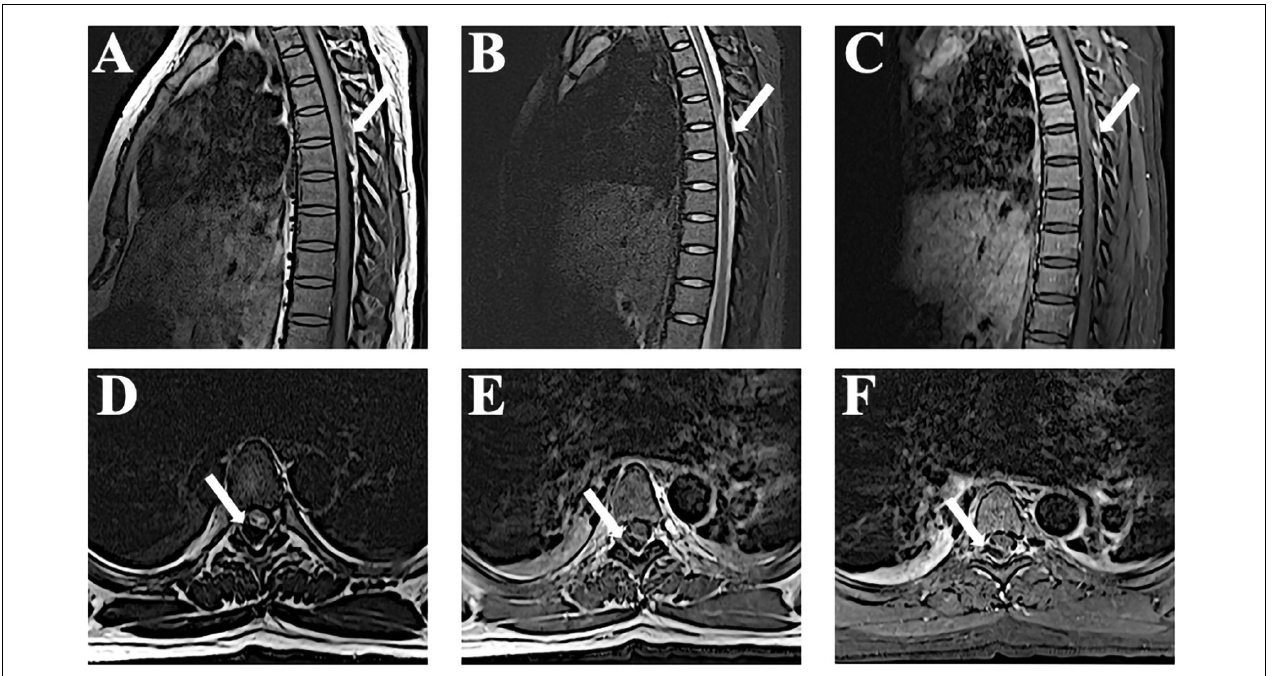
FIGURE 1 | Magnetic resonance imaging (MRI) observations at admission. (A,B) Sagittal T1-weighted magnetic resonance images reveal a lesion at T5–T6 that appears as an isointense signal and T2-weighted shows a hypointense signal. (C) The edge of the hematoma shows mild enhancement after gadolinium administration. (D–F) Axial images show the lesions accordingly.